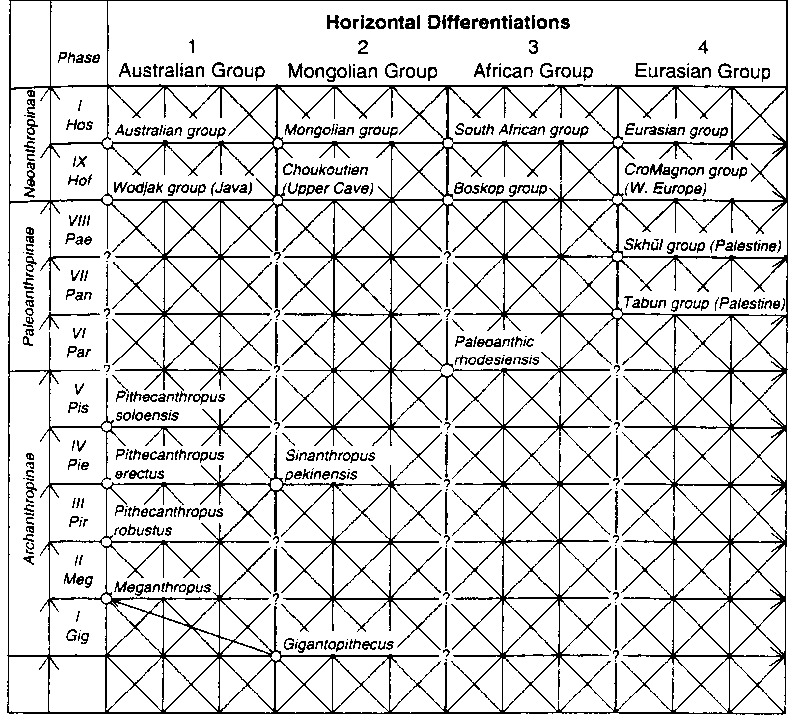
Figure 6. Franz Weidenreich’s 1946 “trellis” model of polycentric human evolution over three